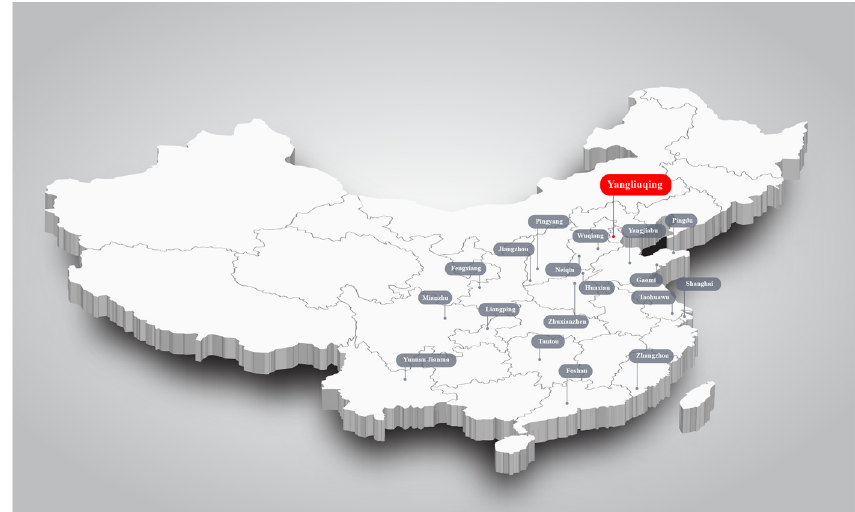
Figure 1. Nineteen origins of New Year prints.